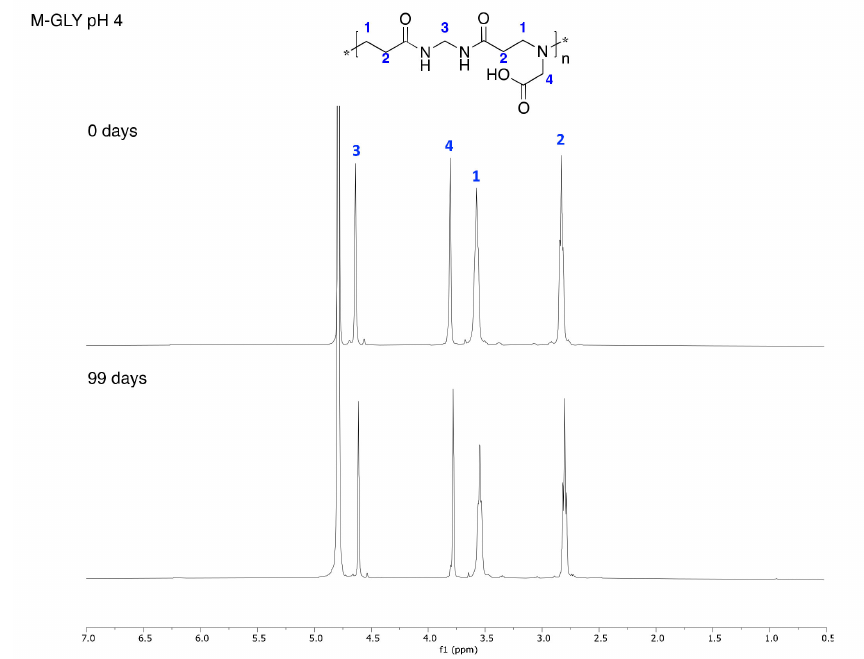
Figure 1. 1 H-NMR spectra of M-GLY obtained in D 2 O at pH 4.0 at di ff erent times using a 400 MHz Avance Brüker spectrometer. Concentration of the repeat unit 43.6 µ